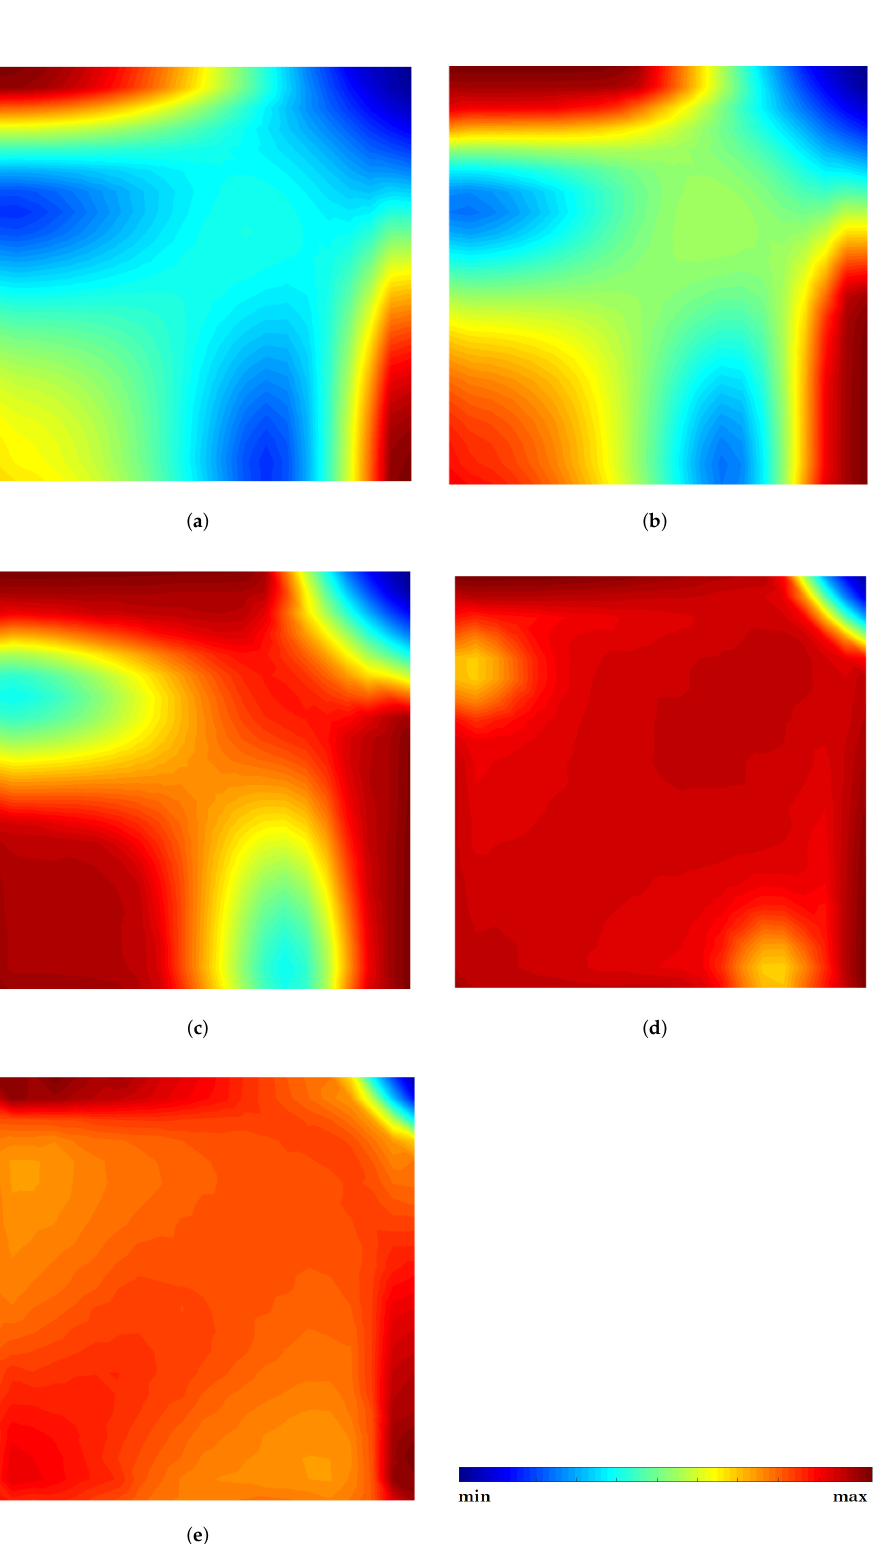
Figure 13. Effective von Mises stress distribution maps obtained with RPIM for five load increments considering the clamped plate. For each load increment, the minimum and maximum effective stresses are: ( a ) f = 1251.68 KN/m 2 : σ min = 0 MPa; σ max = 170 MPa. ( b ) f = 1814.94 KN/m 2 : σ min = 0 MPa; σ max = 205 MPa. ( c ) f = 2378.19 KN/m 2 : σ min = 0 MPa; σ max = 210 MPa. ( d ) f = 2941.45 KN/m 2 : σ min = 0 MPa; σ max = 215 MPa. ( e ) f = 3316.95 KN/m 2 : σ min = 0 MPa; σ max = 220